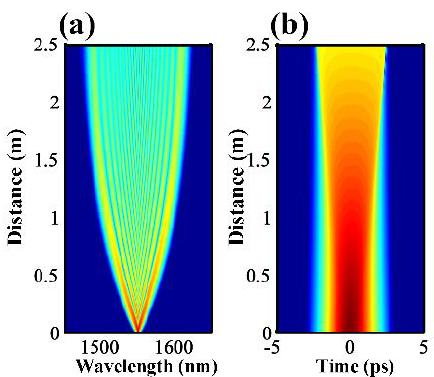
Figure 4. ( a , b ) Evolution of pulses and spectrum in a 2.5 m ND TMF.